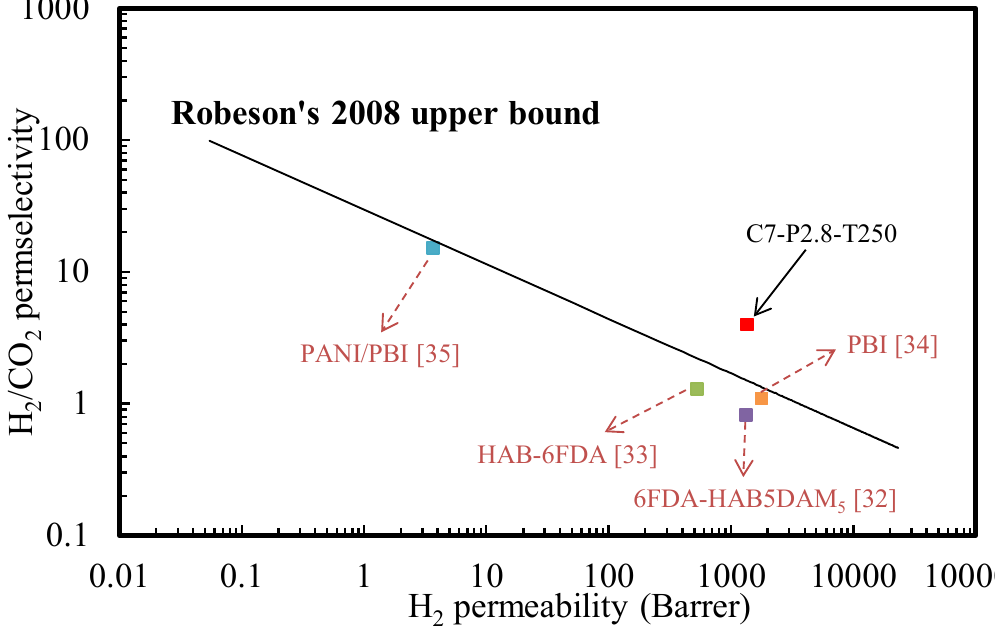
Figure 11. Robeson plot for H 2 /CO 2 separation comparing the rubber-derived TR membrane with other TR membrane prepared by different precursors.